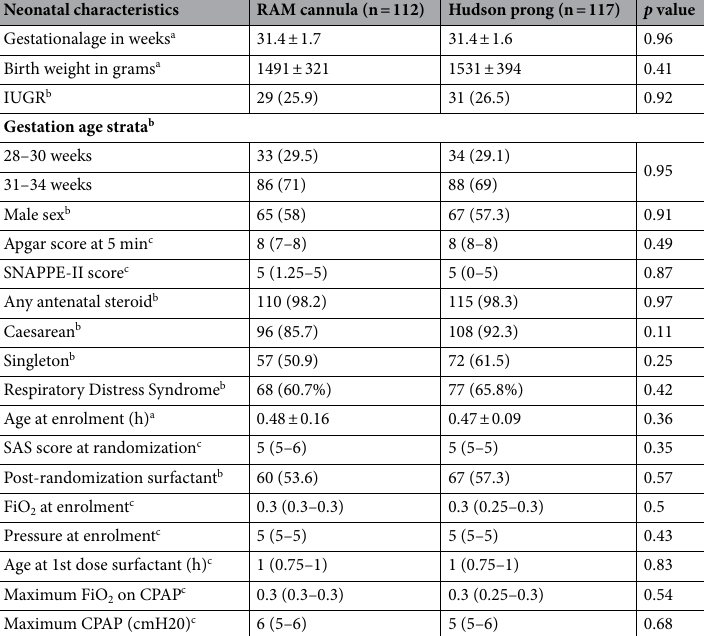
Table 2. Baseline maternal and neonatal characteristics. IUGR intrauterine growth restriction, SNAPPE-II score for neonatal acute physiology with perinatal extension-II, SAS Silverman Anderson score, FiO 2 fraction of inspired oxygen, CPAP continuous positive airway pressure. a Mean ± standard deviation. b n (%). c Median (inter quartile range).